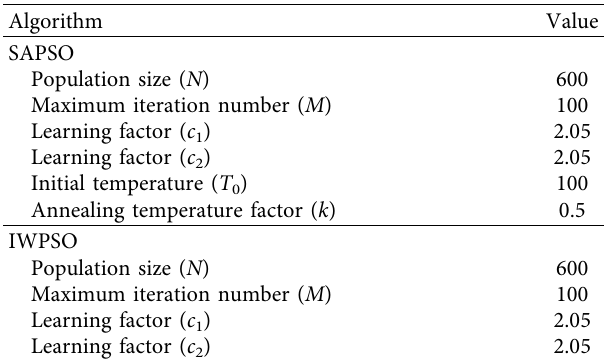
Table 5: Parameters for algorithms.